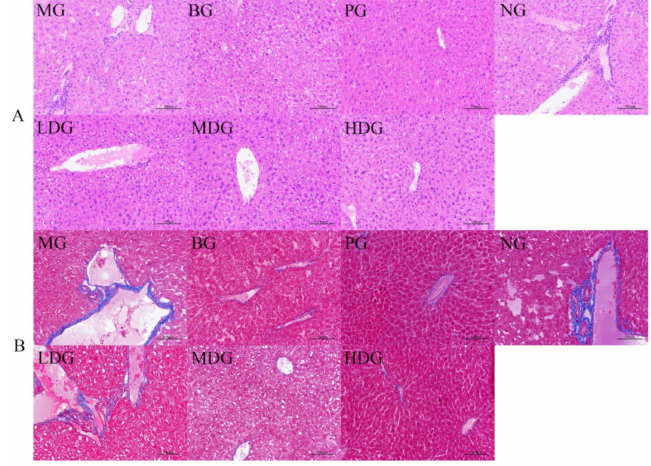
Figure 7. HE staining ( A ) and Masson’s staining ( B ) of liver tissue of mice in each group.